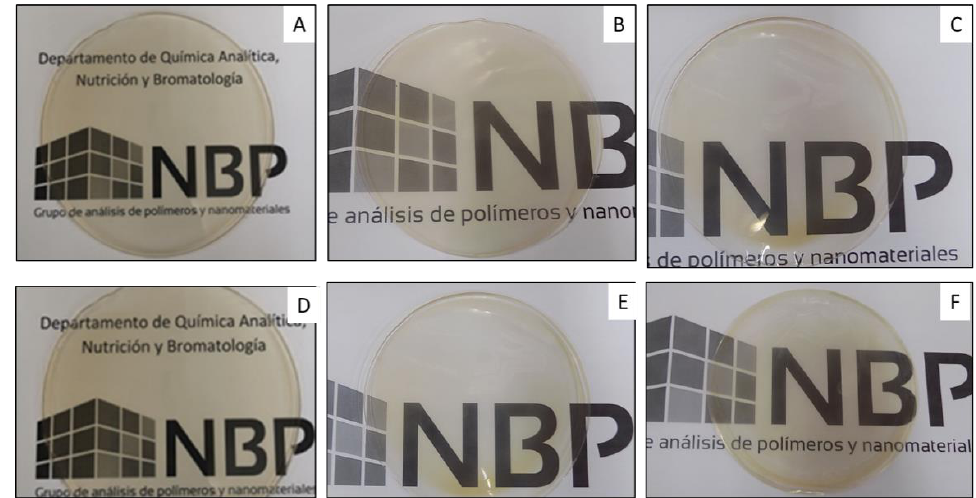
Figure 2. Visual appearance of pectin-based films: ( A ) PC, ( B ) PC-1ZnO, ( C ) PC-3ZnO, ( D ) PC-5E, ( E ) PC-5E-1ZnO and ( F ) PC-5E-3ZnO. Table 3. Colour parameters and transparency of pectin-based films.